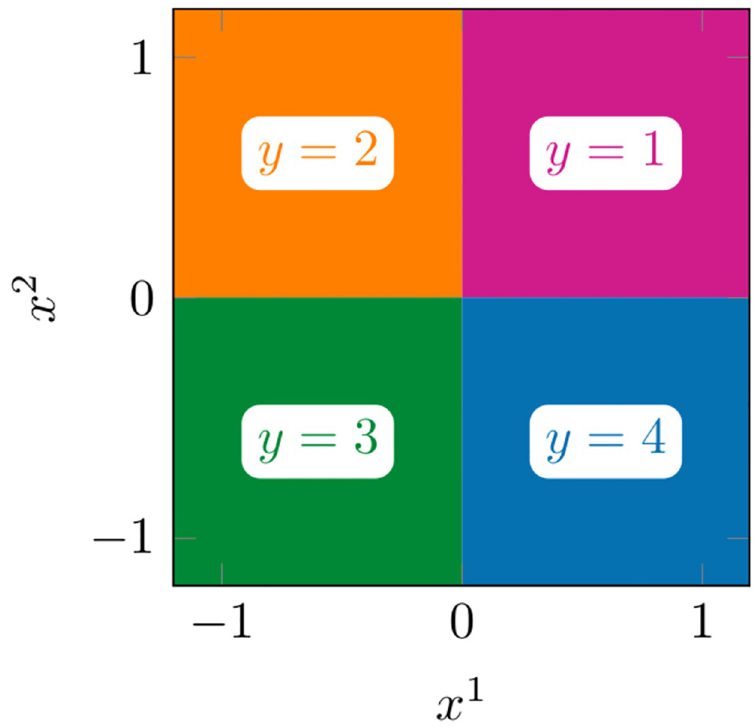
Fig 6. Synthetic data visualization. Illustration of the ground truth (40) for the synthetic data class labels. Synthetic data visualization.